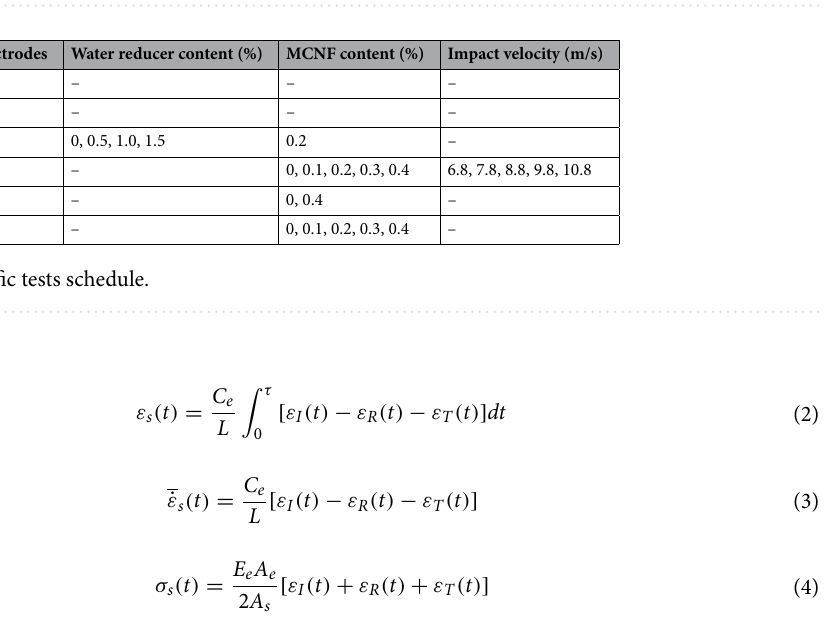
Figure 2. Schematic diagram of SHPB equipment.